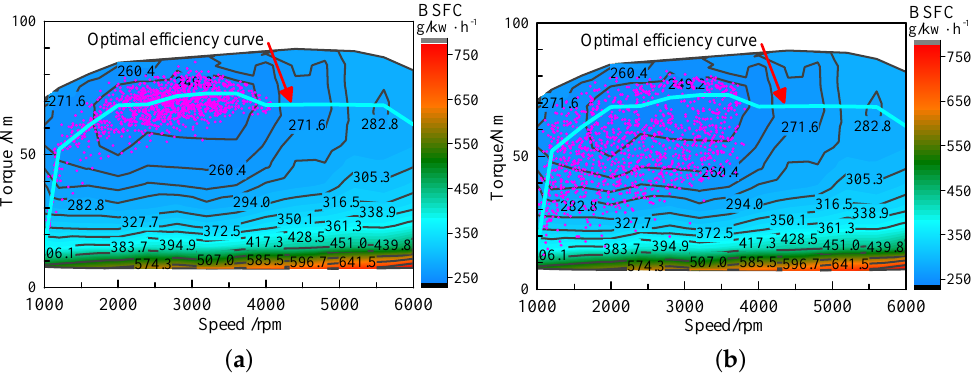
Figure 14. Engine working point comparison. ( a ) IEMC_NN engine working points; ( b ) CD/CS engine working points.